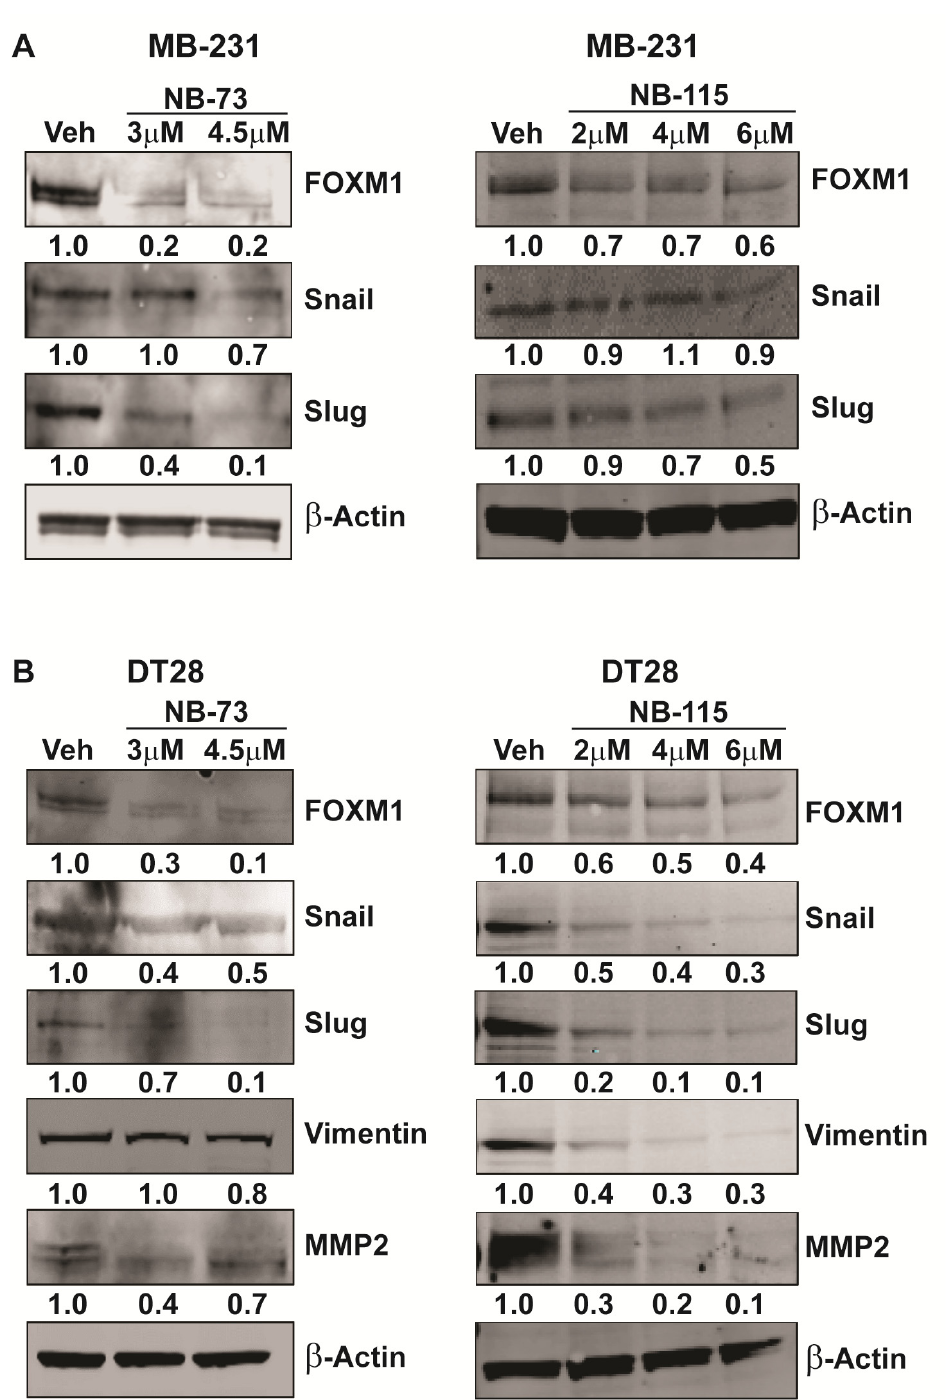
Figure 4. FOXM1 inhibition leads to decreased cellular levels of EMT proteins, Treatment of ( A ) MDA-MB-231 and ( B ) DT28 cells with NB-73 and NB-115 at the concentrations indicated for 24 h and subsequent Western blot analysis for FOXM1 and EMT marker proteins. β -Actin is used as a loading control. Full gel blots are shown in Supplementary Figures S3 and S4.